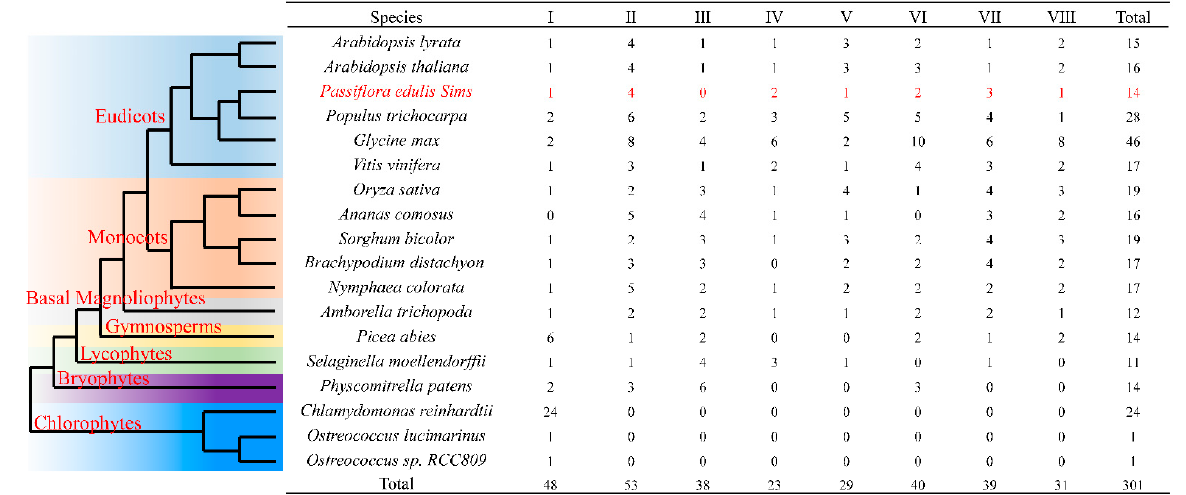
Figure 2. The evolutionary relationship of the SBP gene family of 18 species among seven lineages. Different green plant families are distinguished by different backgrounds.